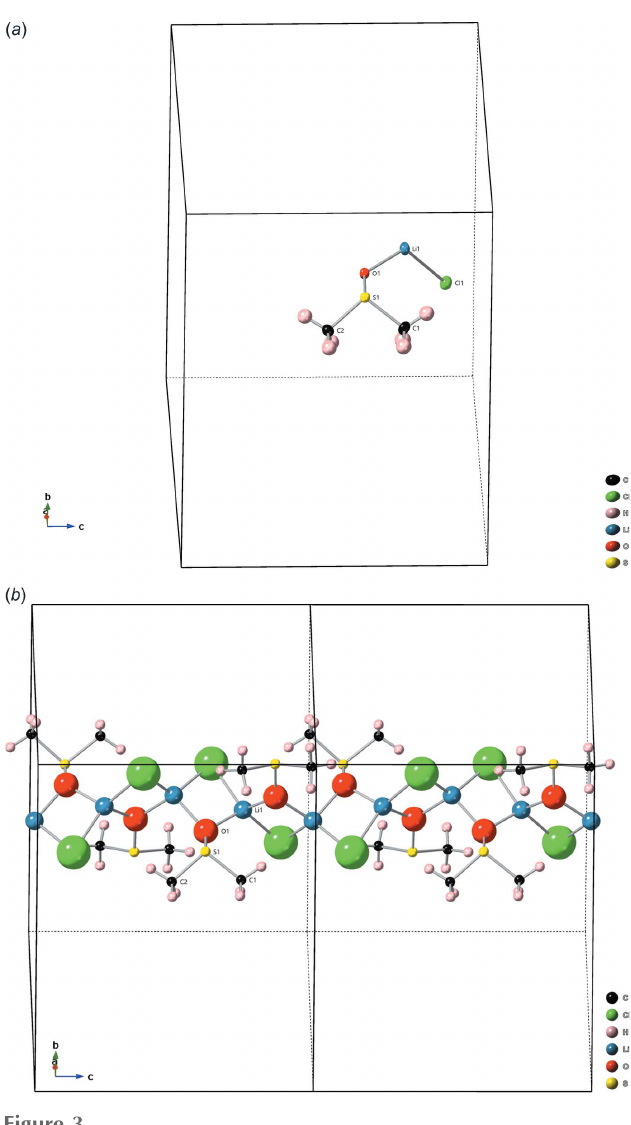
Figure 3 Tetragonal structure: asymmetric unit ( a ) and polymeric chain view ( b ). The repeating unit of the polymer has four LiCl and four DMSO. The DMSO molecules in this structure are not